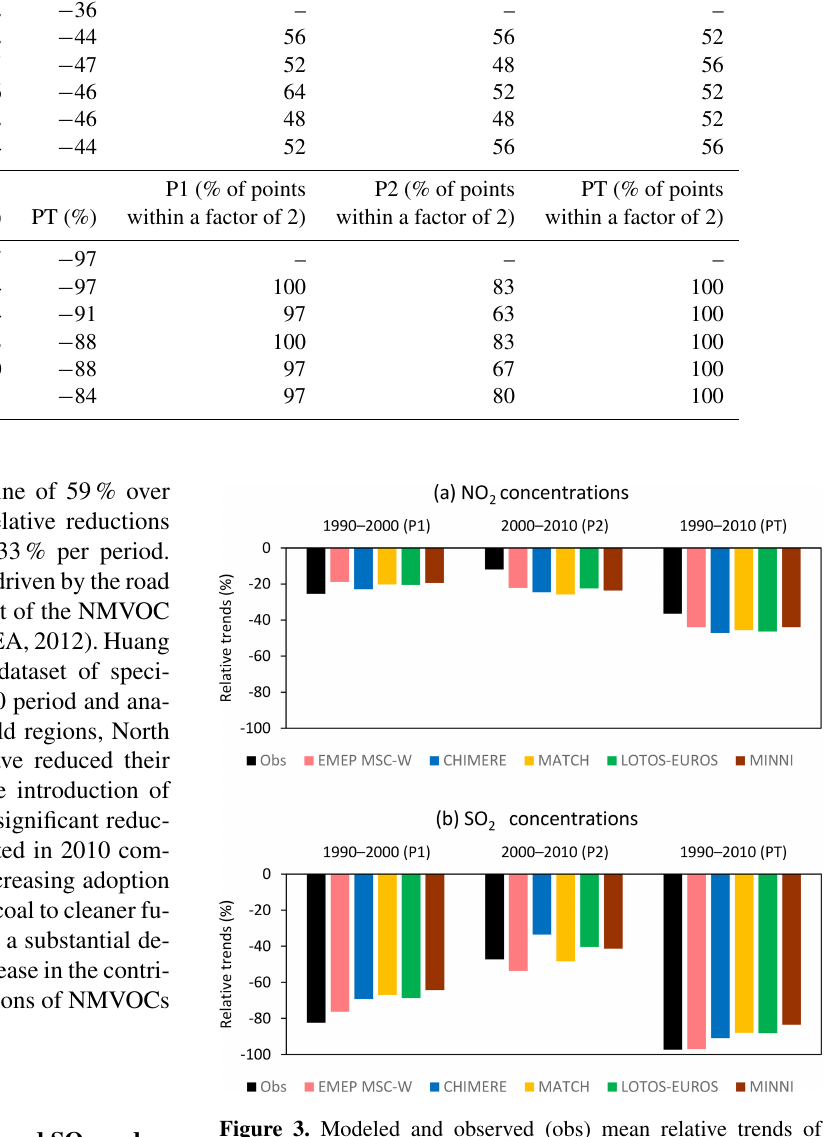
Figure 3. Modeled and observed (obs) mean relative trends